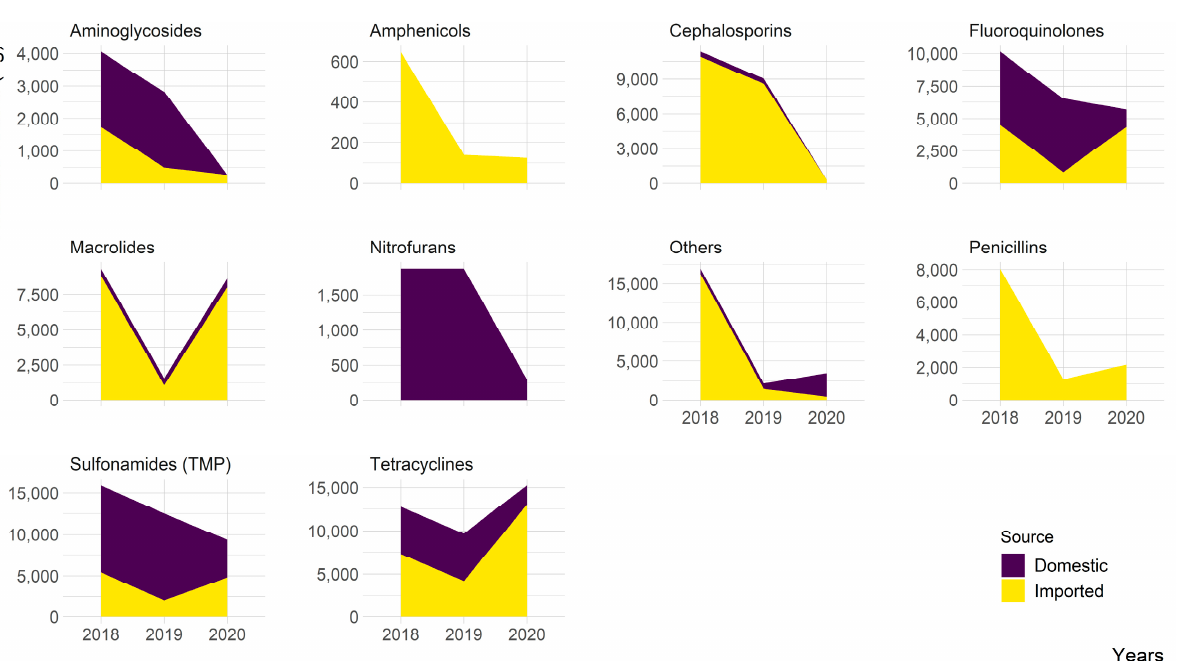
Figure 2. Antimicrobial quantities (by antimicrobial agents and route of administration) reported for use in veterinary medicine in Nepal in 2020.